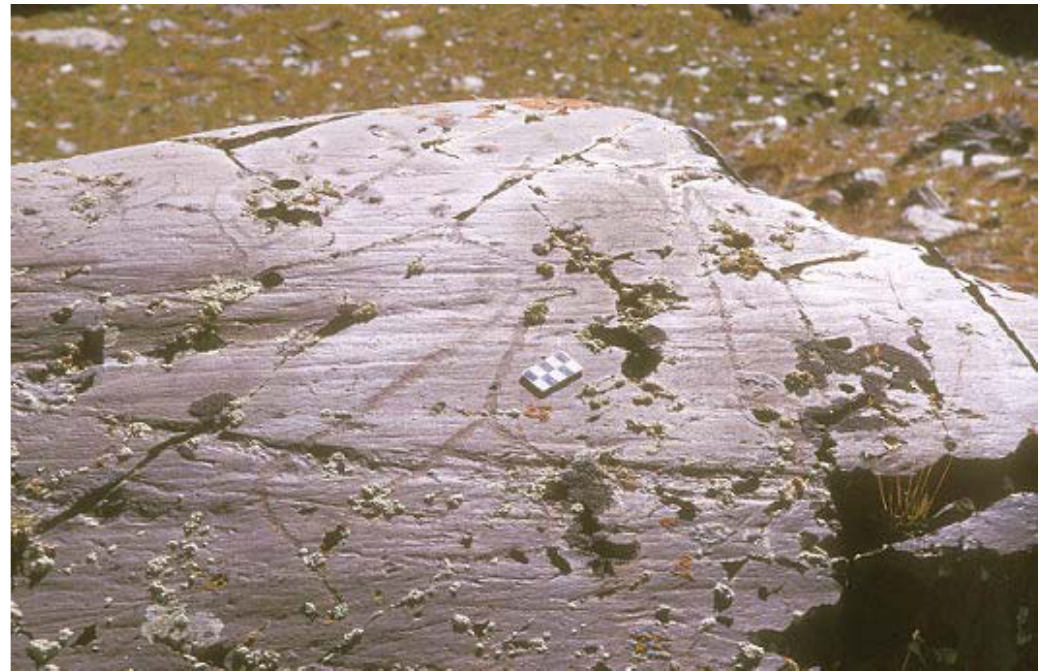
Figure 6. Two contoured elk and an ibex on scraped surface. Pre-Bronze Age. Tsagaan Salaa III. (http://oregondigital.org/u?/maic,774).